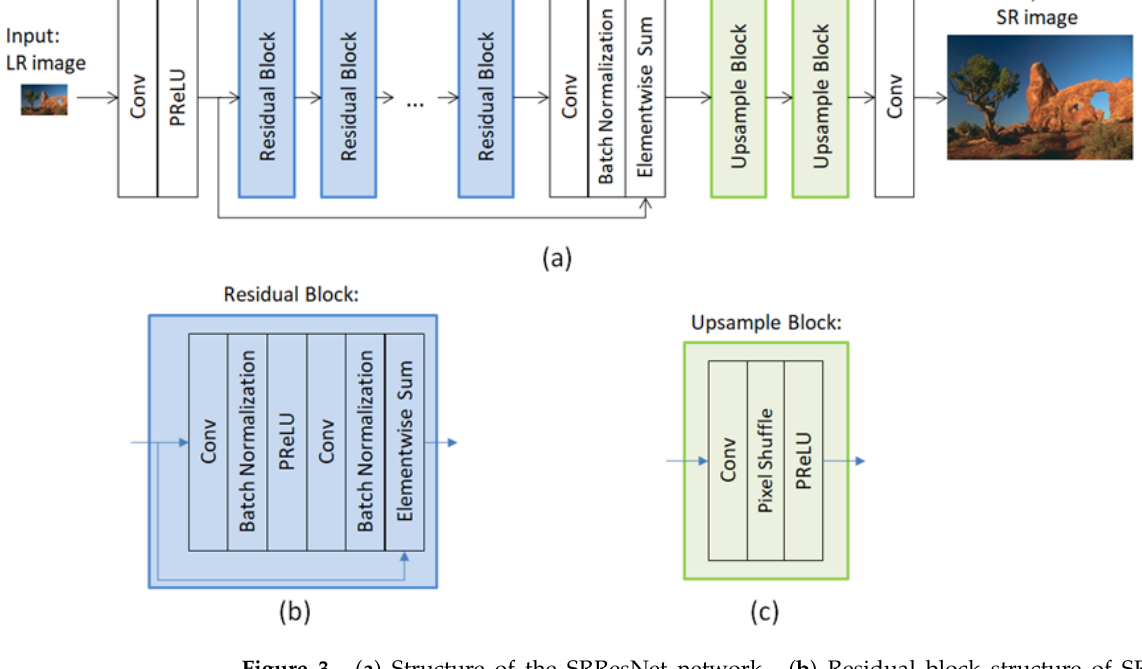
Figure 3. ( a ) Structure of the SRResNet network. ( b ) Residual block structure of SRResNet. ( c ) Upsampling block structure of SRResNet.